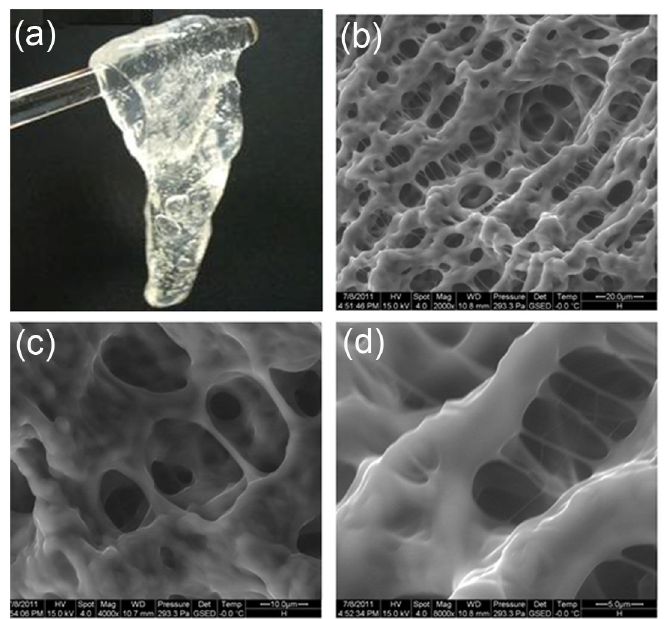
Figure 3. ESEM images of zirconium cross-linked polymer gels. (a) The bulk gel cross-linked by 0.6 % PAM and 1.6 % zirconium acetate; (b)-(d) Microstructure of the bulk gel at 2,000×, 4,000× and 8,000× magnification, respectively. doi: